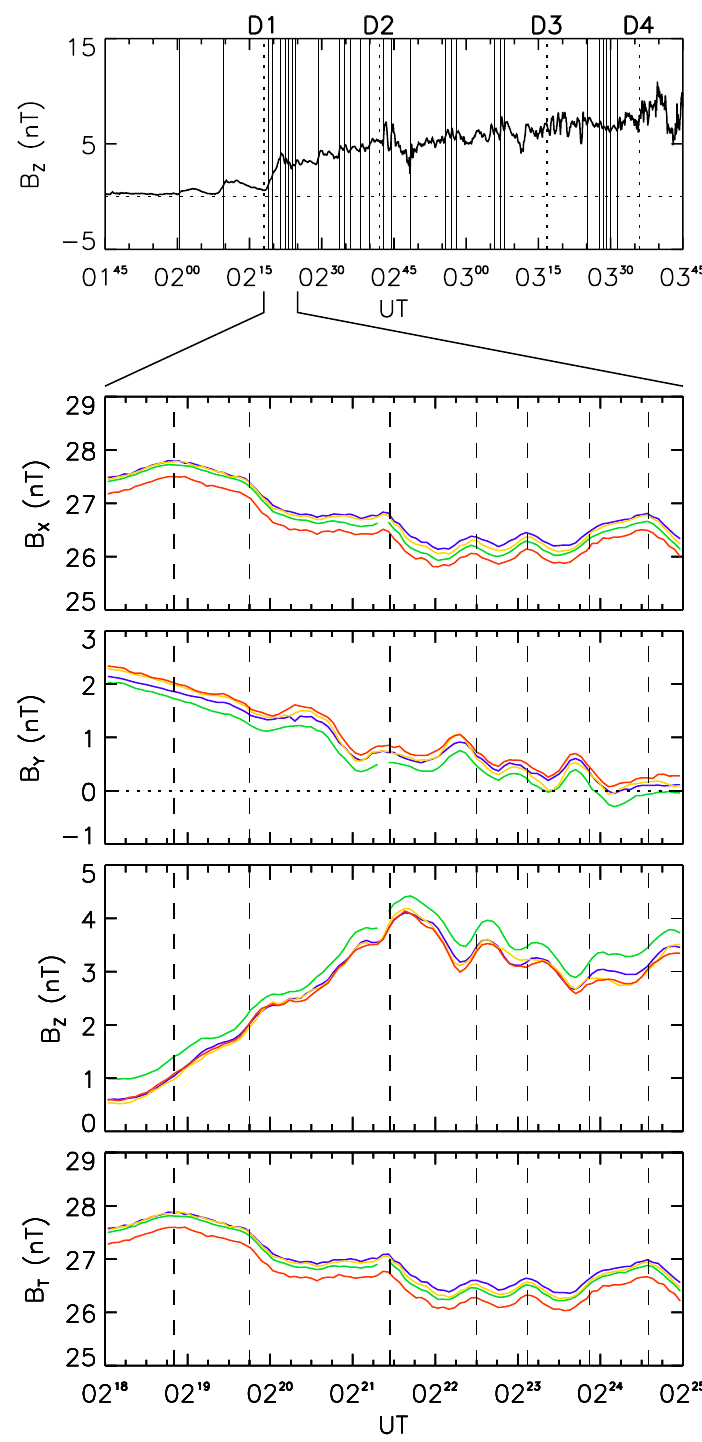
Fig. 4. Cluster 1 observations of B z from 01:45 to 03:45 UT, showing the occurrence of compression regions associated with plasma sheet flux ropes, together with detailed observations of the event characteristics in B x , B y , B z , and B T components measured at all four spacecraft between 02:18 and 02:25